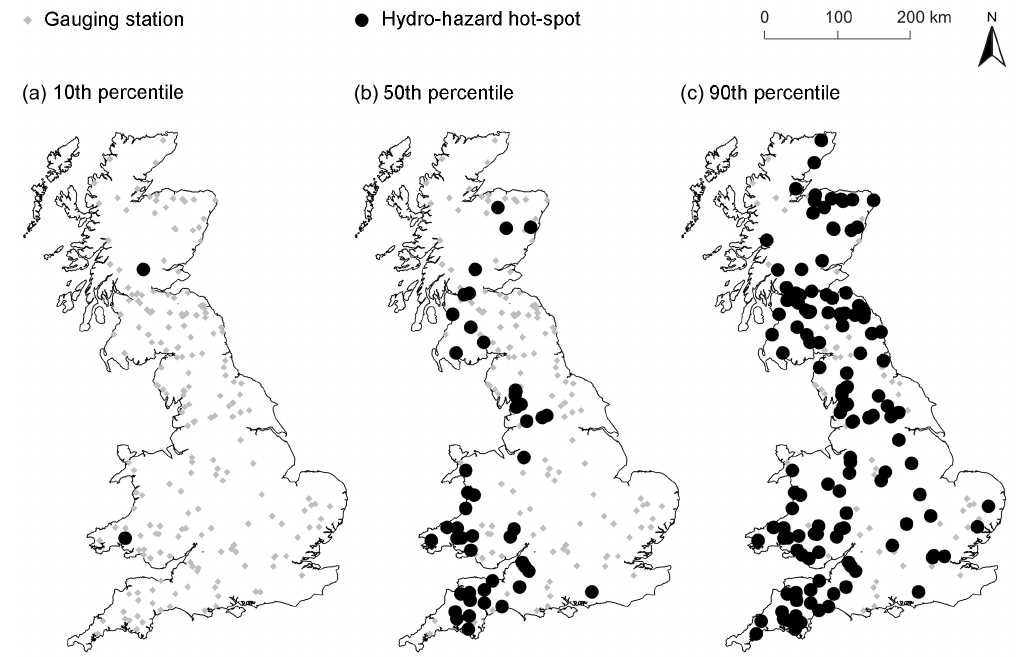
Figure 4. Hydro-hazard hot-spots in Great Britain for the (a) 10th, (b) 50th, and (c) 90th percentiles.